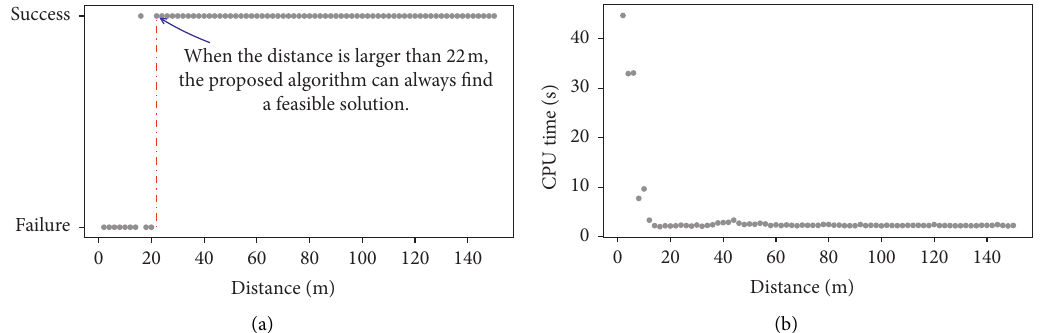
Figure 13: Effect of the distance between vehicle 0 and vehicle 4. (a) Effect of the distance on the feasibility of the algorithm. (b) Effect of the distance on the computational load of the